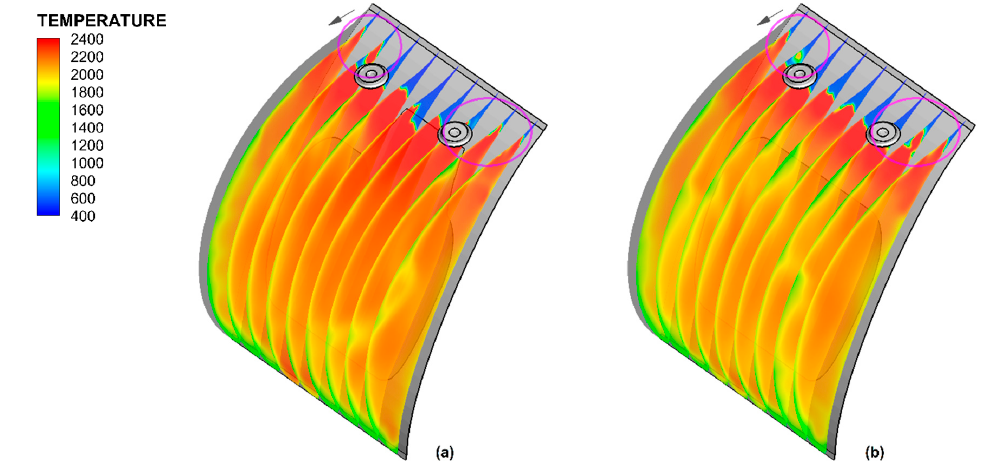
Figure 10. Temperature (K) distribution at 140°EA after TDC (160°EA after ST) for ( a ) L-slot and ( b ) N-slot cases.